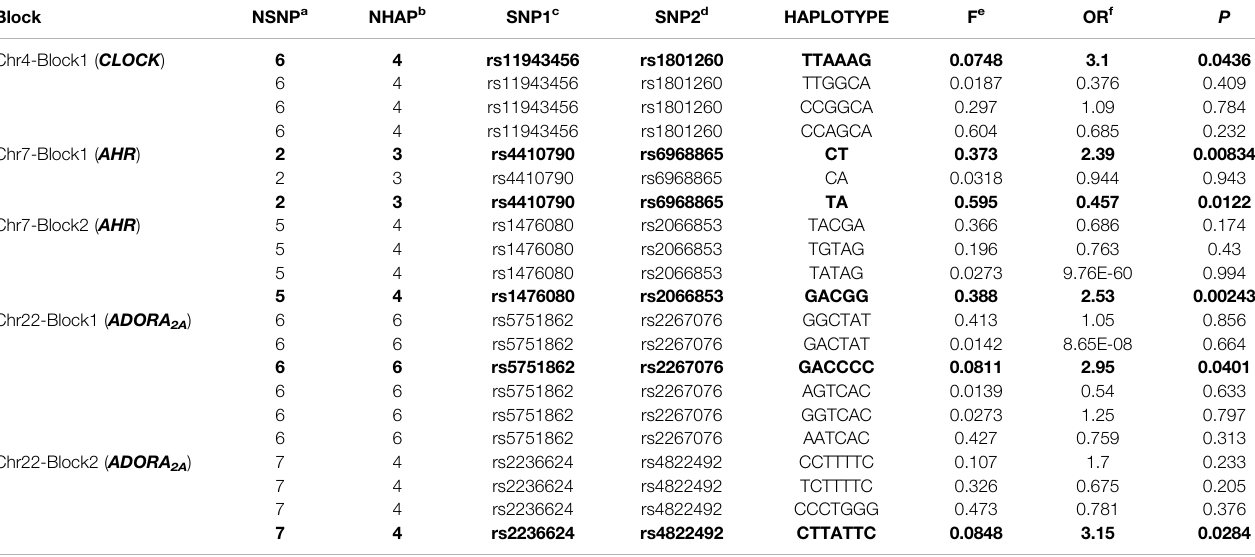
TABLE 4 | Signi fi cant associated haplotype